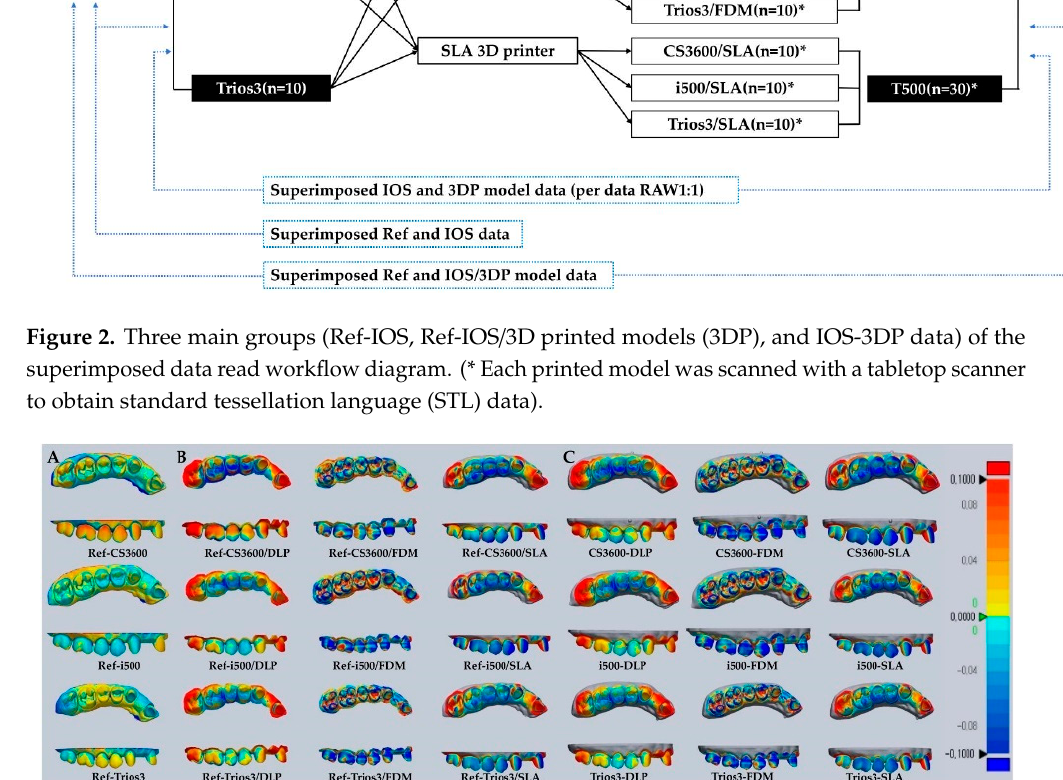
Figure 4. Surface characteristics of three different types of (( A ) digital light processing (DLP), ( B ) fused deposition modeling (FDM), and ( C ) stereolithography apparatus (SLA)) 3D printed models. In the present study, the differences in digital data deviation could be explained by the density of polygons formed by IOS and 3D printing data; Rapidform software was used for data analysis. IOS and 3DP data were selected and tooth data were investigated from three areas: teeth #13 (MxC), #14 (MxFPM), and #16 (MxFM) (Figure 5). Typically, IOS data showed a higher density (polygons per unit area) relative to 3DP data. When polygon images acquired by software were investigated, the stitch density of various types of triangular polygon shapes was high in complex shapes with many anatomical details. Triangle polygons overlapped by stitching between IOS groups showed a